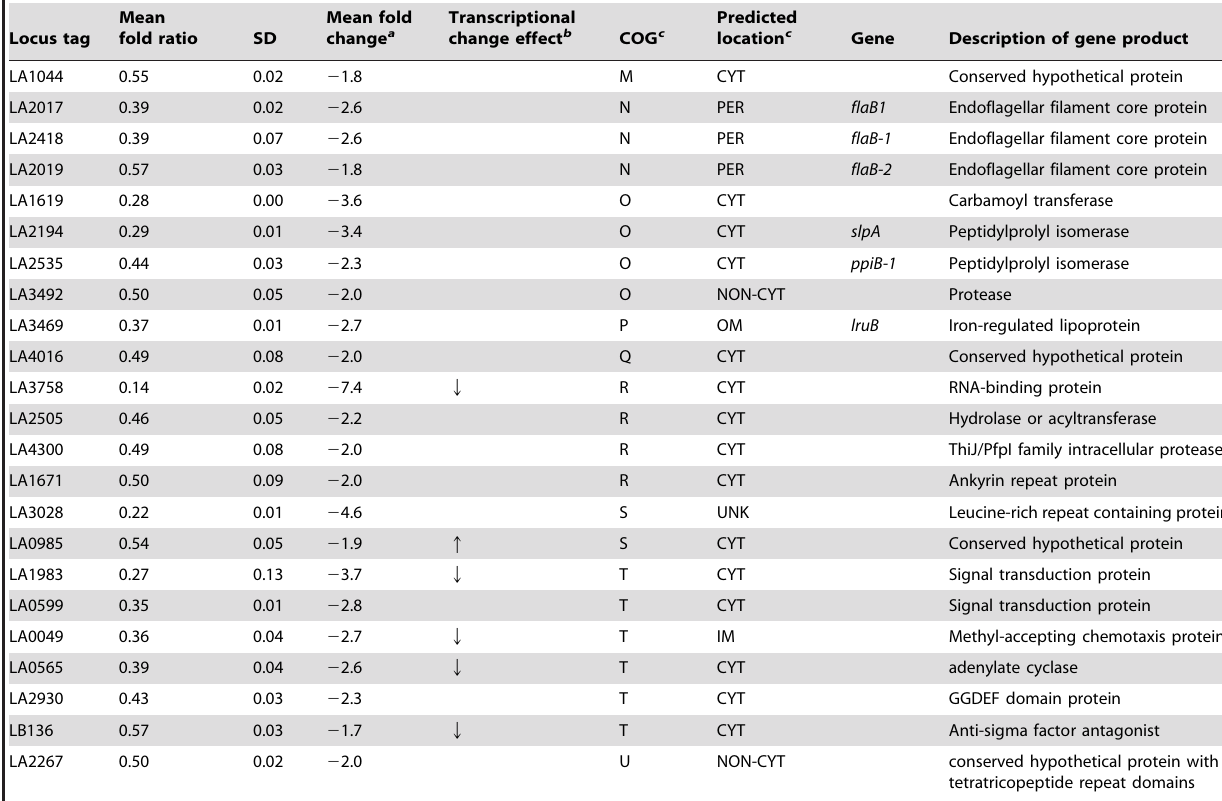
c COGs and predicted locations as per Table 2.